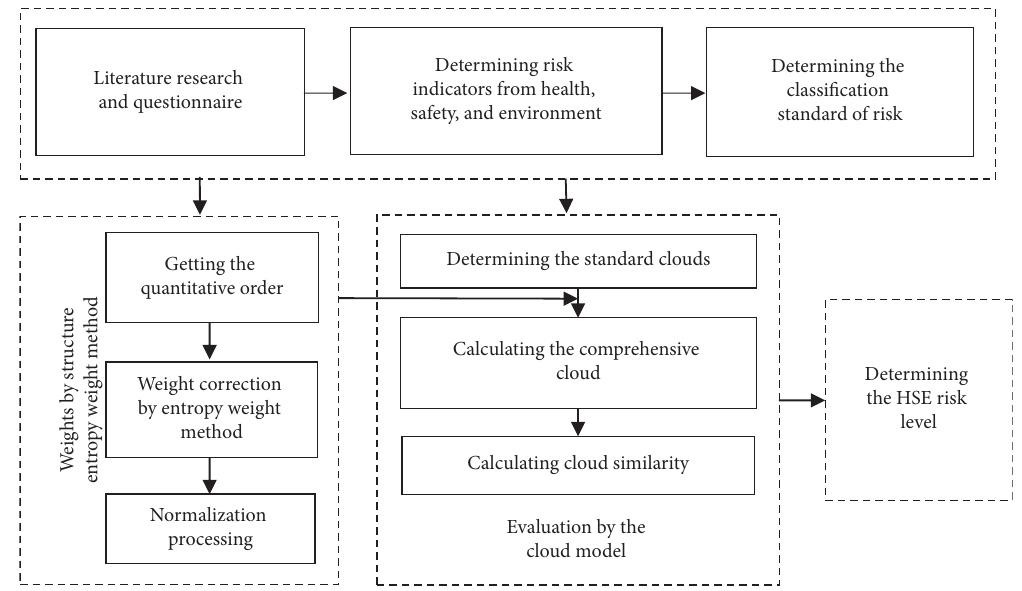
Figure 1: Flow chart of risk assessment method of MSTTPs based on the SEWM and the cloud